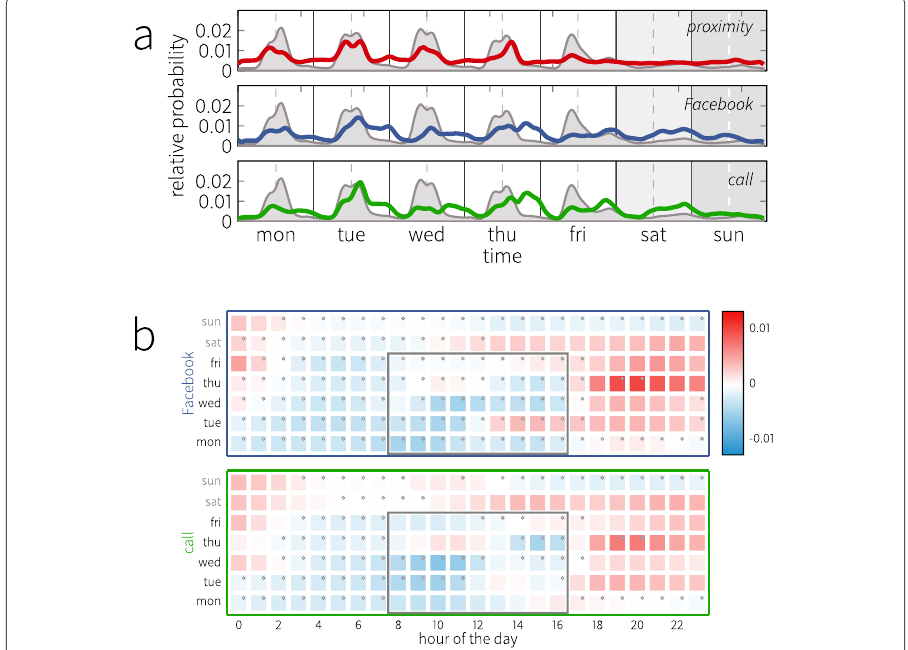
Figure 3 Contact activity of central individuals in the proximity network. (a) Relative probability of physical contacts, compared to the distribution of the population average (grey area). Dark regions indicate weekends. (b) Heat maps showing the difference in the contact activity between the social core and the proximity driven for each hour in a week. The periods for working hours are surrounded by the grey frame. In all cases, the 10 most central individuals are considered, and results are aggregated over a four month period between February and May 2014 (inclusive). Hours of significant difference are marked by the white